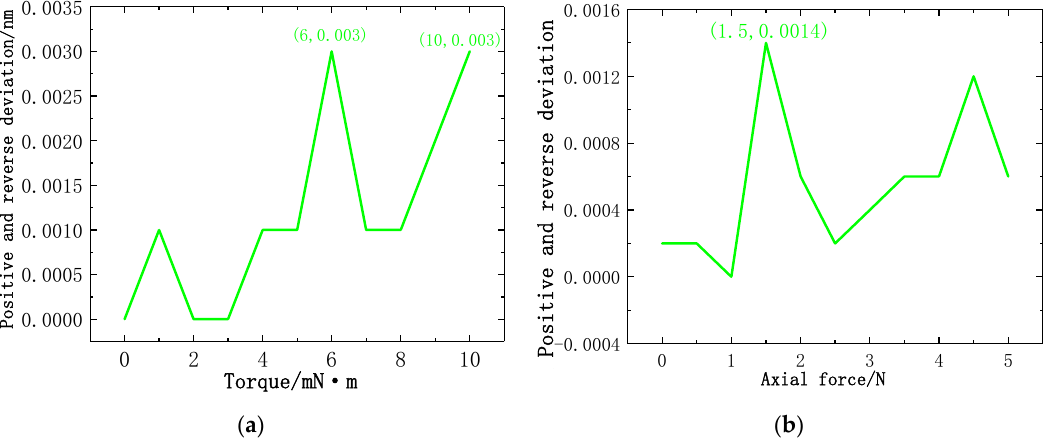
Figure 17. Line chart of positive and reverse deviation: ( a ) Positive and reverse deviation of torque; ( b ) Positive and reverse deviation of axial force.